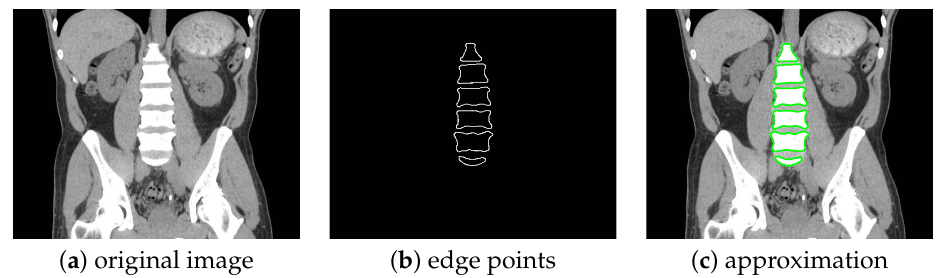
Figure 11. Recognition and approximation of different profiles from a human lumbar spine. The orig- inal image ( a ) is treated to obtain the edge points ( b ). The six approximations are given in ( c ).